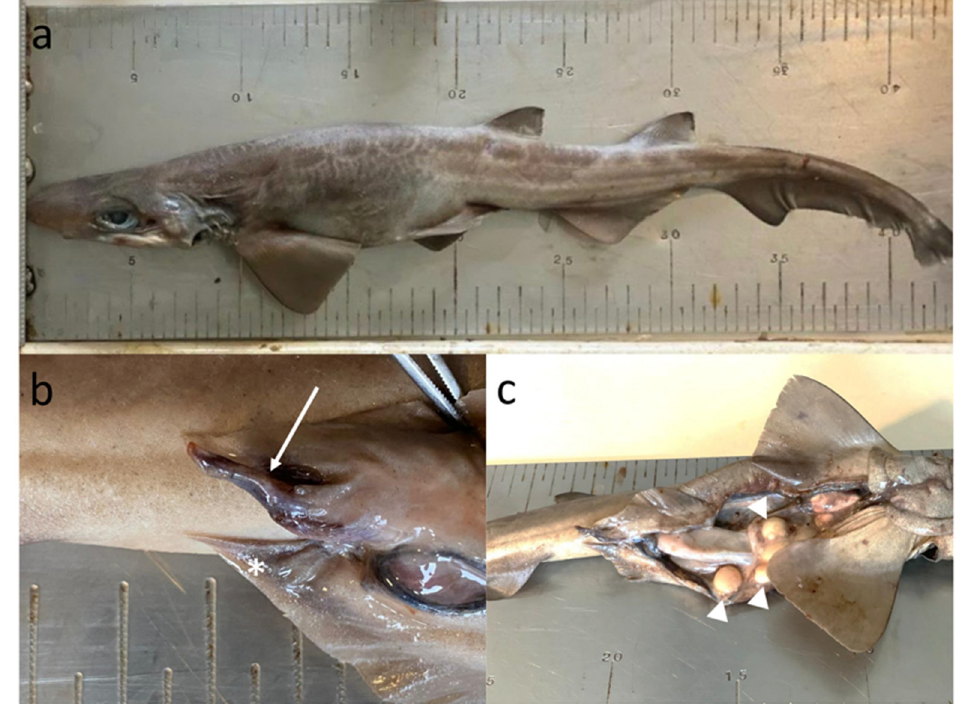
Figure 2. External lateral view ( a ) of the Galeus melastomus specimen caught in southern Tyrrhenian Sea, with a particular view of secondary male sexual organs ( b ) and primary female sexual organs ( c ). Arrow indicates the external right clasper; asterisk indicates the location of the absent right clasper and arrow heads indicate the large yellow